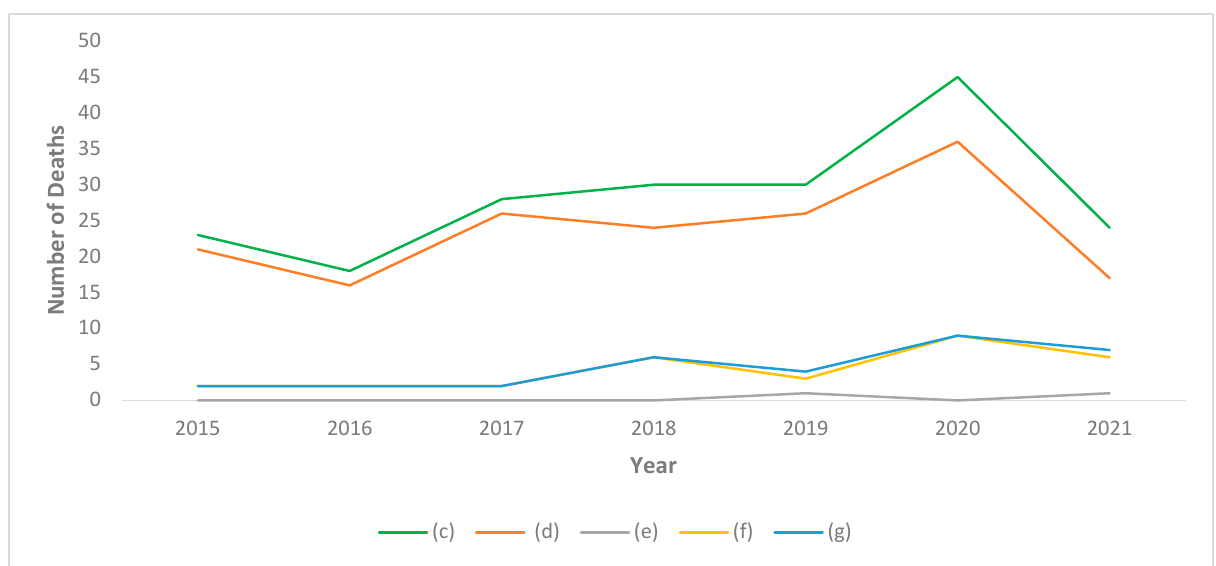
Figure 3. Number of deaths and mortality rate in the population of the province of Pavia (b).